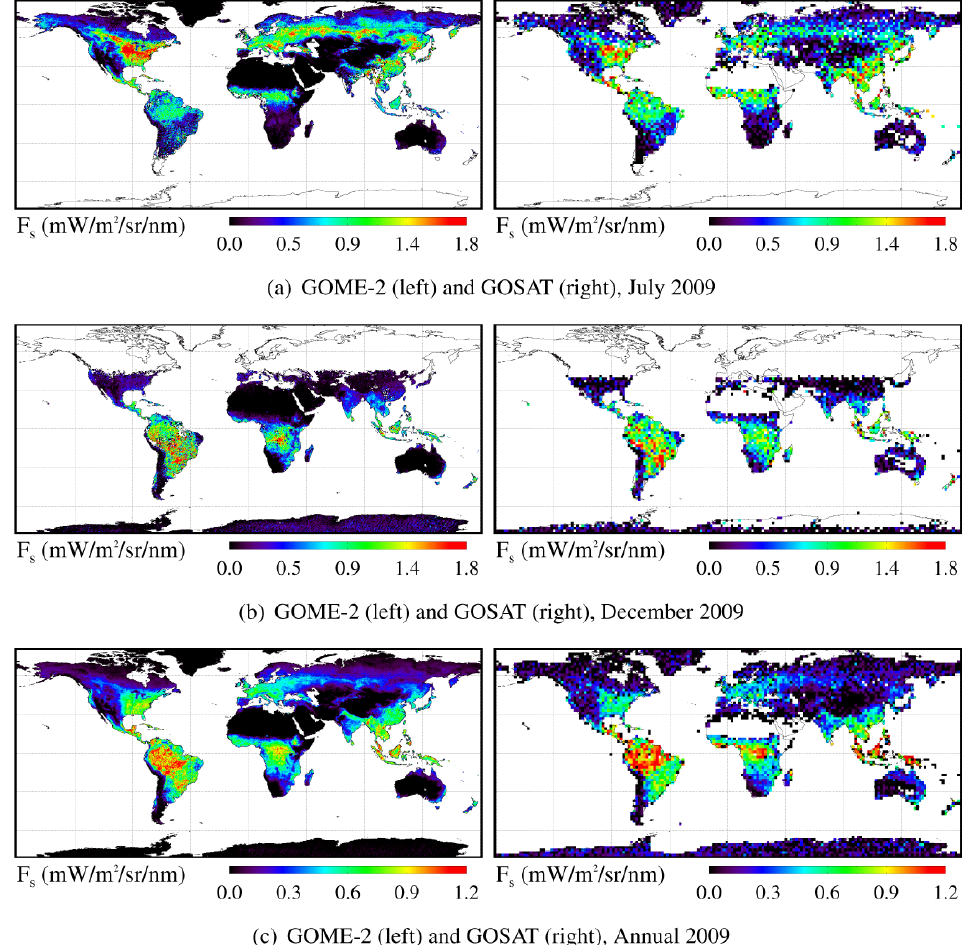
Fig. 15. Global composites of F s from GOME-2 (left) and GOSAT-FTS (right) retrievals for July (top), December (middle) and the annual (bottom) average in 2009 (June 2009 through May 2010 for GOSAT). GOME-2 are binned in 0.5 ◦ cell boxes; GOSAT retrievals binned in 2 ◦ cell boxes. Both retrievals refer to wavelengths near